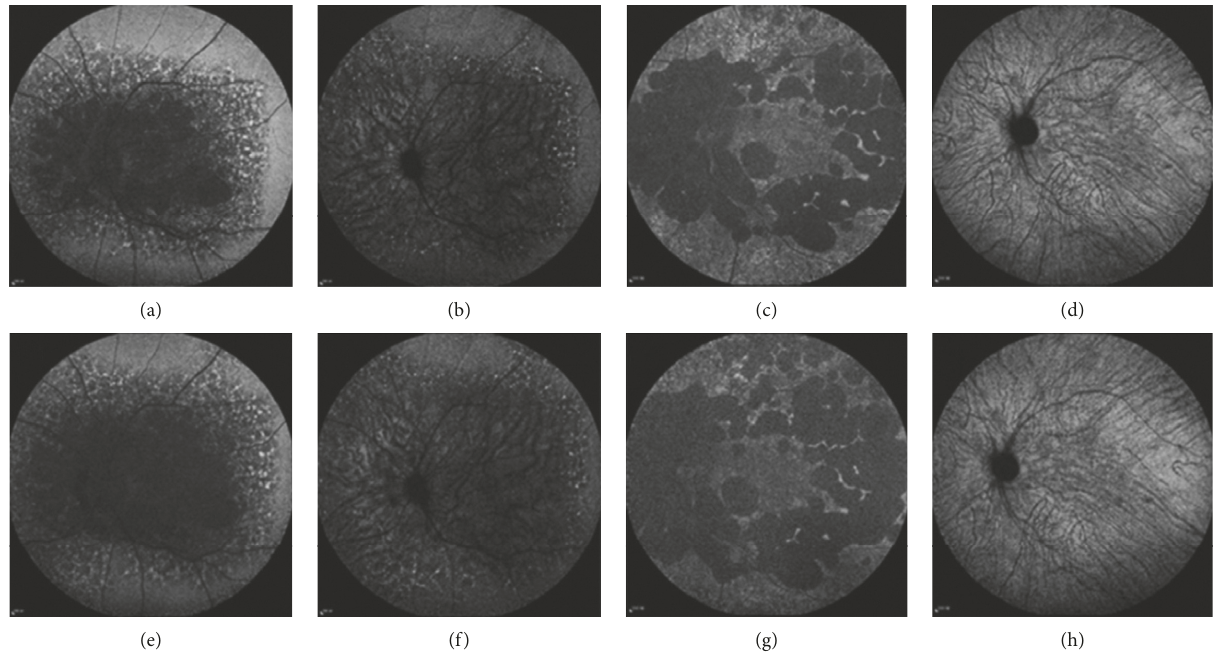
Figure 3: Comparison of first and last fundus autofluorescence (AF) and infrared autofluorescence (IRAF) images in patients with type 1 and type 2. (a, e): First and last AF images, respectively, of the left eye of type 1 patient P1, showing enlarged area of hypo-AF at the posterior pole. (b, f): First and last IRAF images, respectively, of the left eye of P1, showing the expansion of hypo-IRAF area in the posterior pole. (c, g) First and last AF images, respectively, of the left eye of type 2 patient P4, showing that the range of hypo-AF around the macula area expanded at the posterior pole, with no significant AF change in the macula area. (d, h): First and last IRAF images, respectively, of the left eye of P4, showing no significant change of the posterior